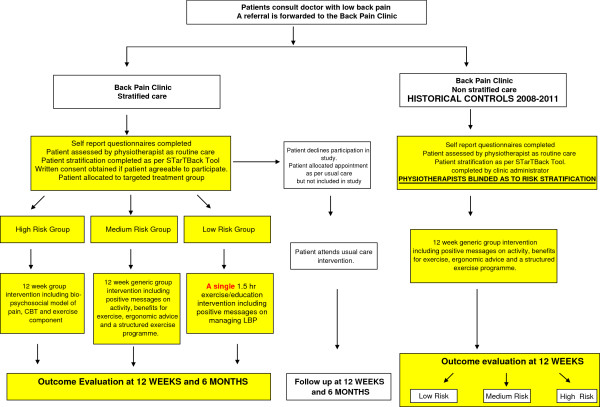
Study flow chart.